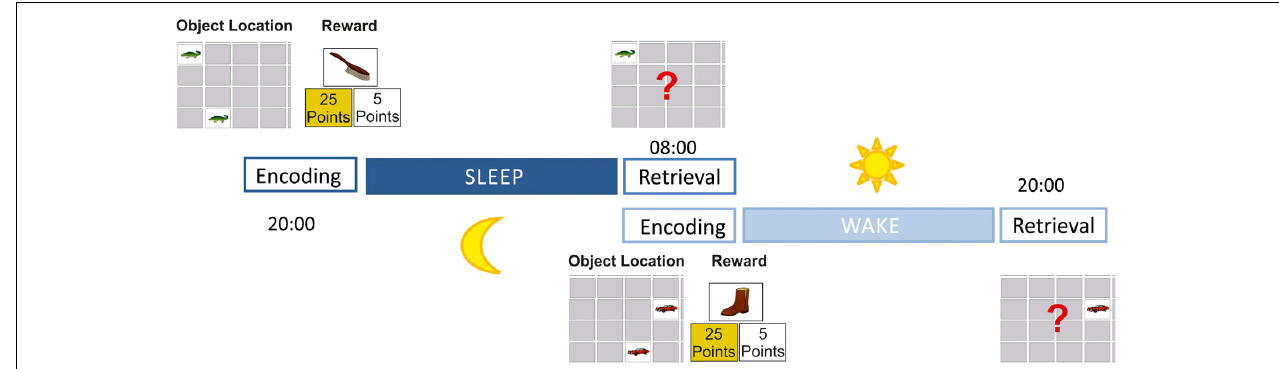
FIGURE 1 | Study design. During encoding participants first learned 18 object locations (learning criterion: 77%) without any cues of allocated reward values; participants then learned to determine which of the object locations were associated with a high and which were associated with a low reward (learning criterion: 100%); at the retrieval session participants were asked to find as many object locations as possible to receive a maximum reward. While encoding was conducted in the evening and retrieval was performed in the morning after sleep in the sleep condition, the encoding session was done in the morning and retrieval in the evening without sleep in between in the wake